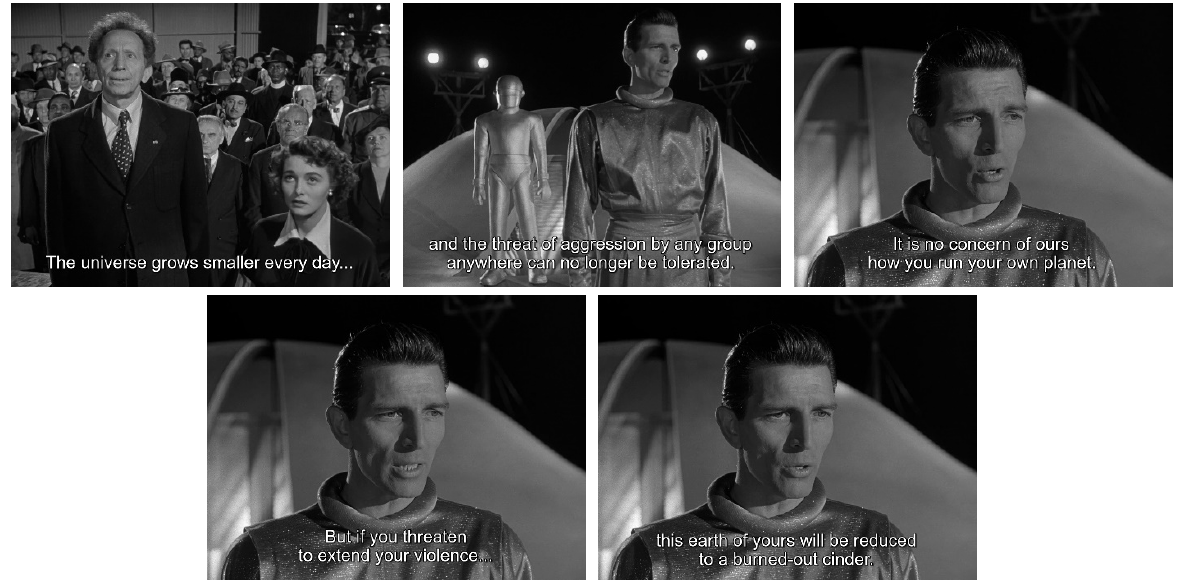
Figure 3. Klaatu’s sole concern about ‘aggression’ and ‘violence’. The Day the Earth Stood Still © 20th Century Fox. All Rights Reserved.